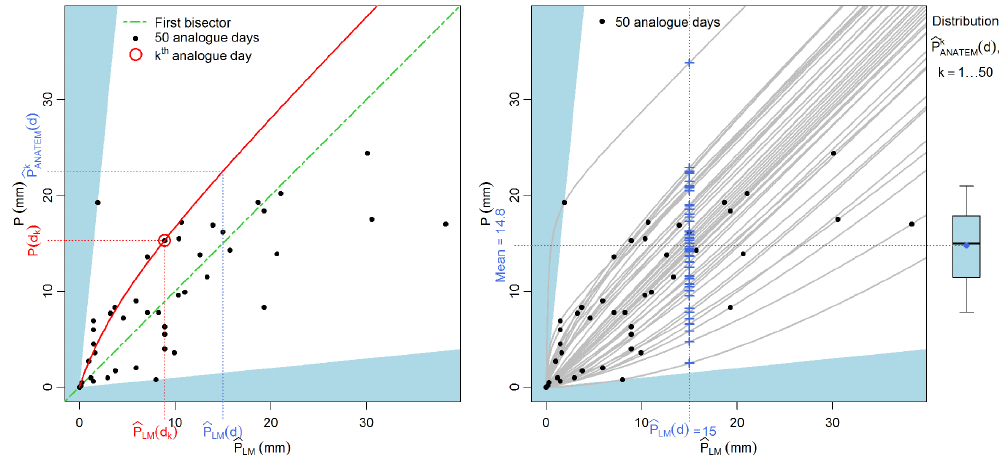
Figure 5. Representation of the ANATEM formulation for precipitation reconstruction for a given day d . Left panel: observed precipitation at the target site for each of the analogue days as a function of the precipitation estimate from LM for the same days. For a given analogue day k , the corrected estimate for day d is the ordinate of the point on the red curve (defined by Eq. 9) crossed by abscissa b P LM (d) . Right panel: probabilistic prediction obtained for d from the 50 analogues. The corresponding boxplot (10, 25, 50, 75 and 90% quantiles) is given to the right of the figure (the blue point indicates the mean